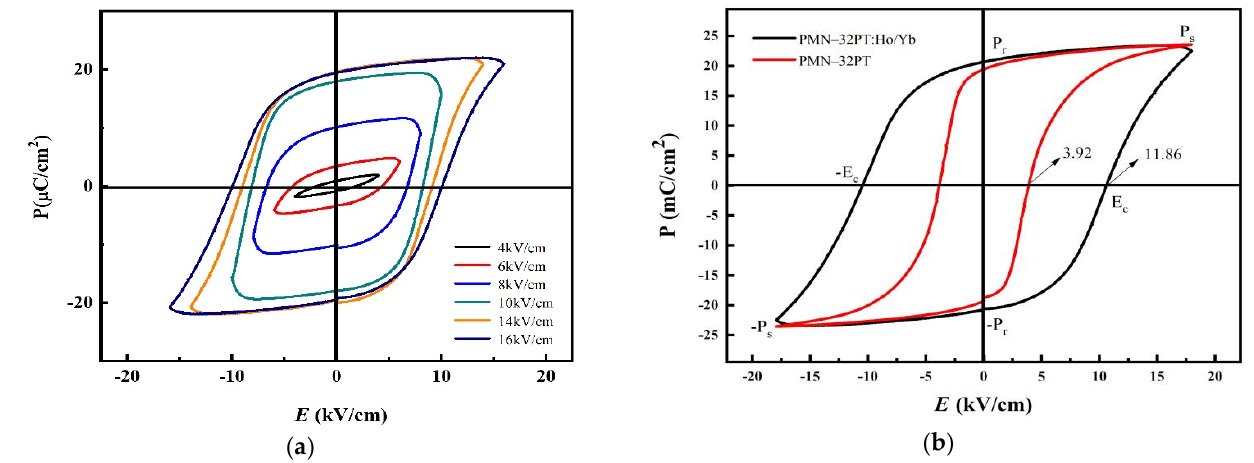
Figure 4. ( a ) Polarization versus electric field ( P–E ) hysteresis loops with different electric fields ( b )P–E hysteresis loops of the crystals PMN–32PT:Ho 3+ /Yb 3+ and PMN–32PT at saturated state.